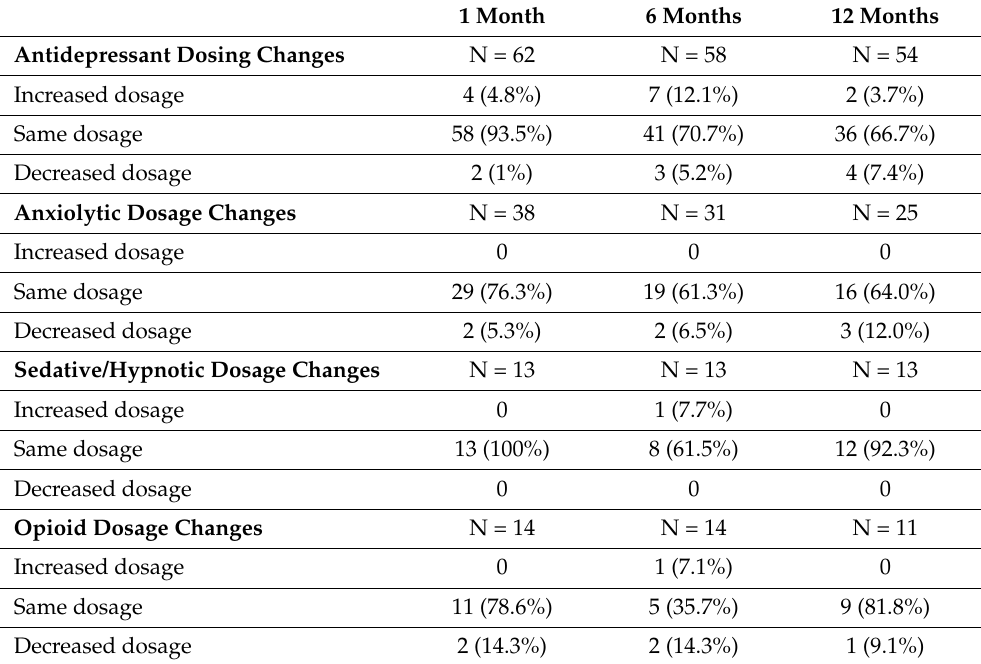
Table 4. Concomitant Medication Dosage